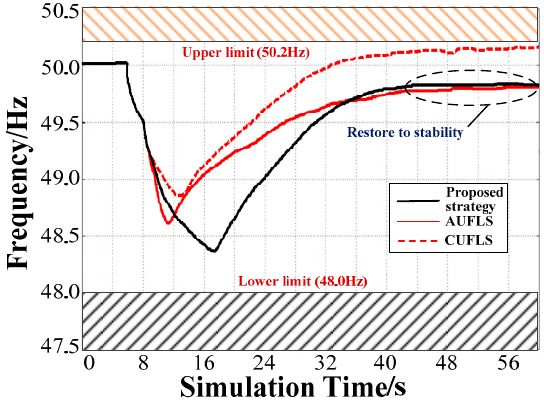
Figure 7. The frequency recovery process of each strategy under scenario-2.